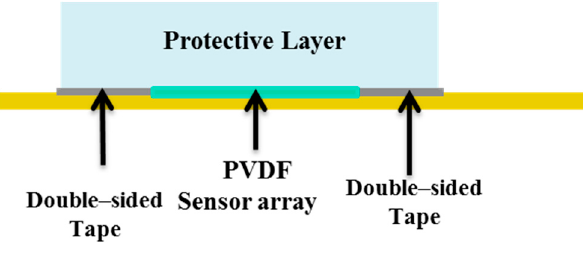
Figure 5. The applied coupling scenario .